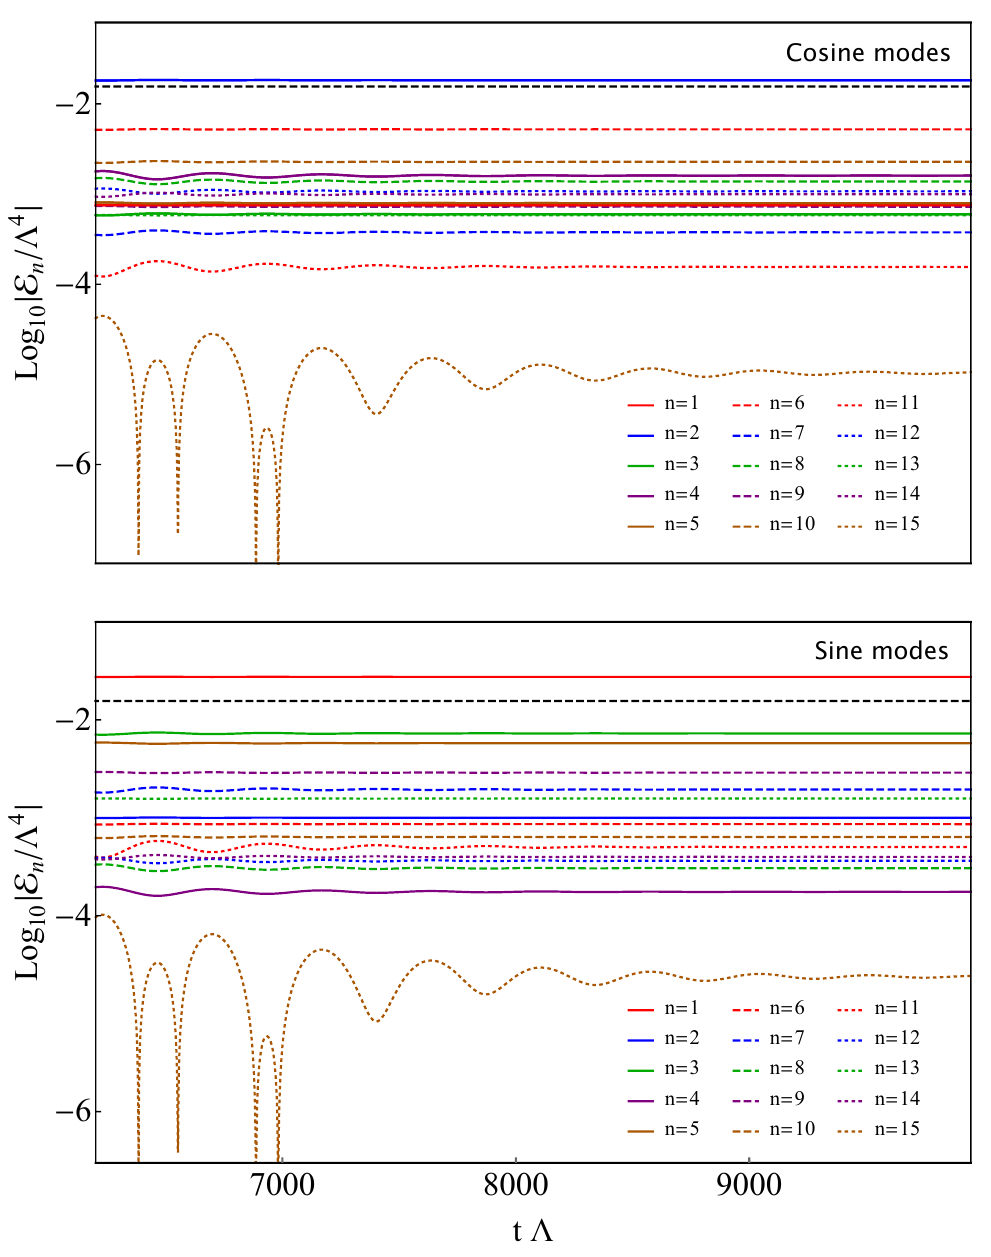
Figure 18 . Late time evolution of some Fourier modes of the energy density shown in (cid:12)gure 4(left). The black, dashed horizontal lines at the top indicate the average energy density or, equivalently, the n = 0, constant